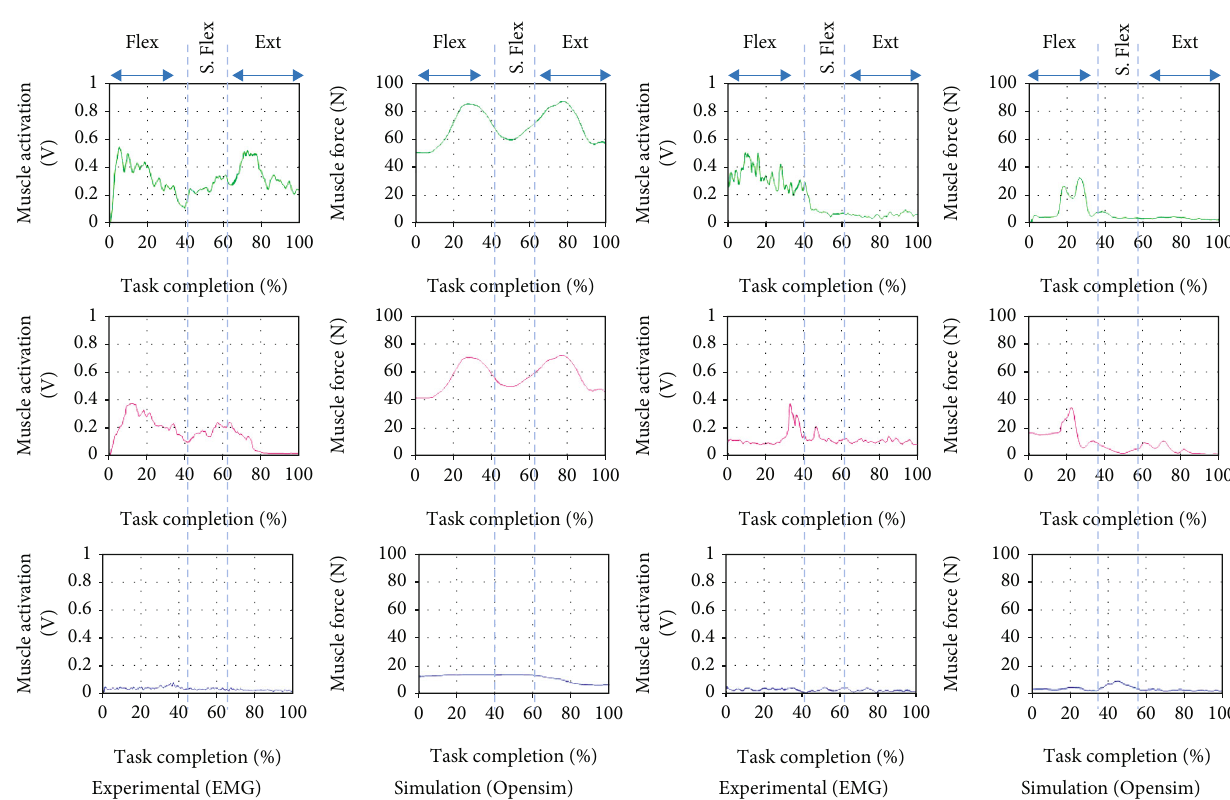
Figure 11: Comparison of EMG from experimental and muscle activations computed from OpenSim resulting in three muscle force brachioradialis (green), biceps (magenta), and triceps(blue) for maximum shoulder fl exion and extension motion with and without the assistive device. ∗∗ (Flex: fl exion; S. Flex: shoulder fl exion; Ext: simulated static task. For each of the three simulated dynamic upper limb movements, we computed an outcome measure of the muscle activity for each muscle of interest (brachioradialis, biceps, and triceps). The muscles ’ location is shown previously in Figure 7.